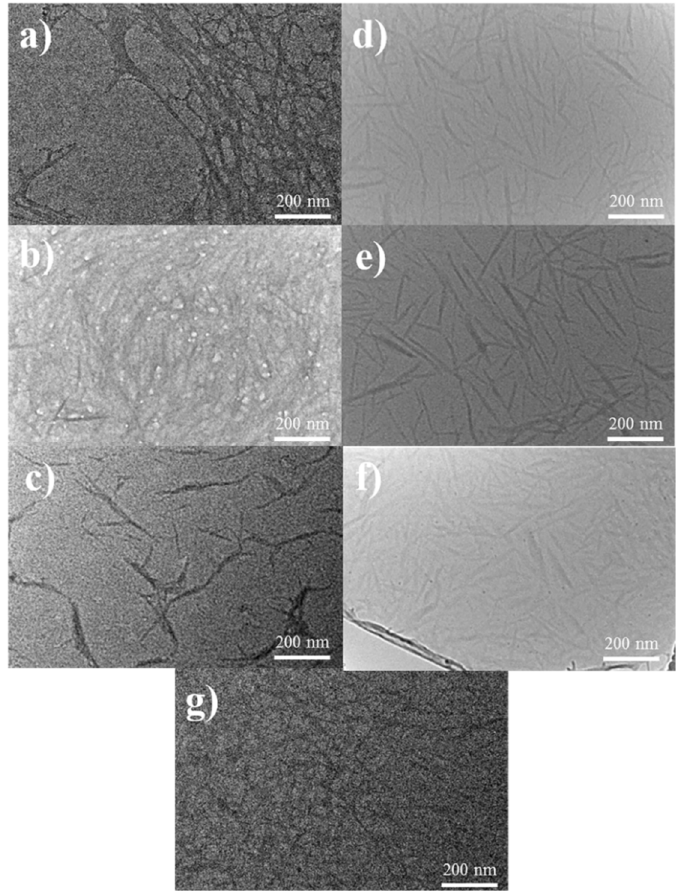
Figure 2. TEM images of the CNFs. ( a ) WCNF, ( b ) WCNF1, ( c ) WCNF2, ( d ) BCNF, ( e ) BCNF1, ( f ) BCNF2, ( g ) PCNF.